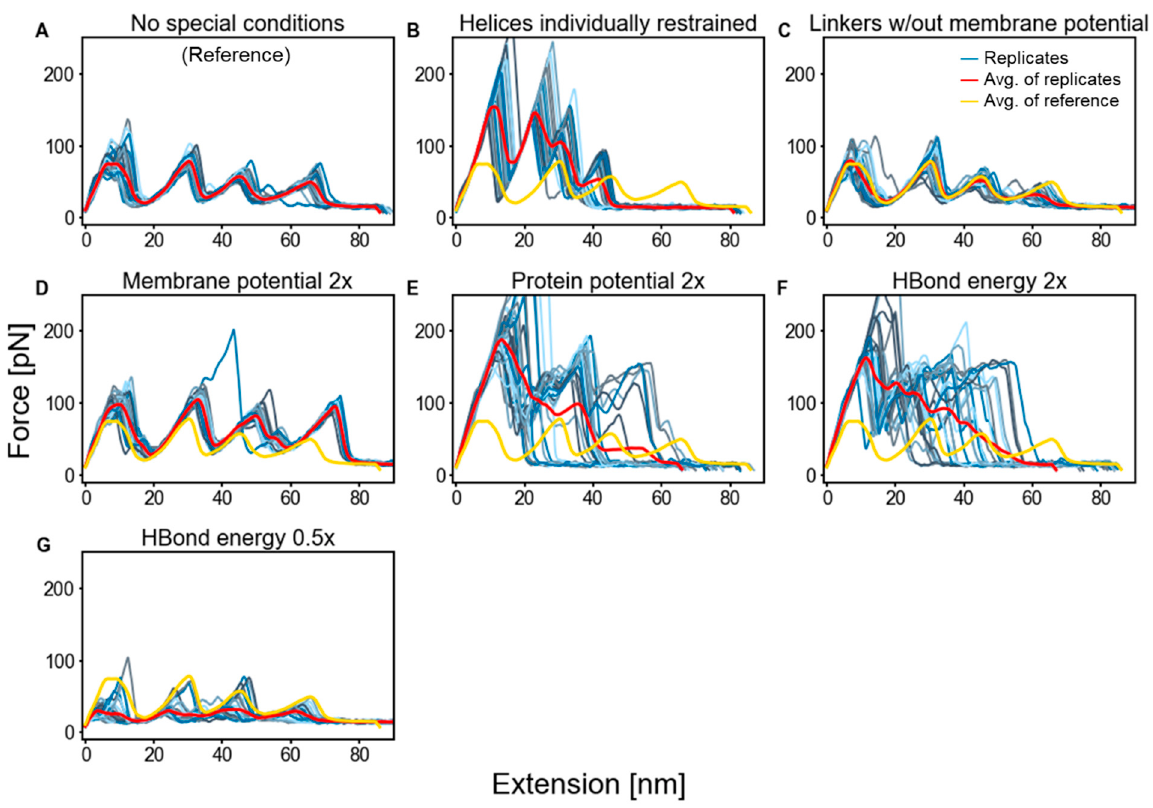
Figure 2. FECs of bR simulations with altered energy terms employing vertical pulling with a stiff spring. Each condition had 28 replicates. The data were smoothed by taking a simple moving average over 50 trajectory frames. In panels ( B – G ), the red lines are the average FECs for each of the six altered conditions, while the yellow lines are the average FECs for the unaltered condition from Panel ( A ) and are provided as a reference for the reader’s benefit. Table 1. E and D helices’ average rupture force